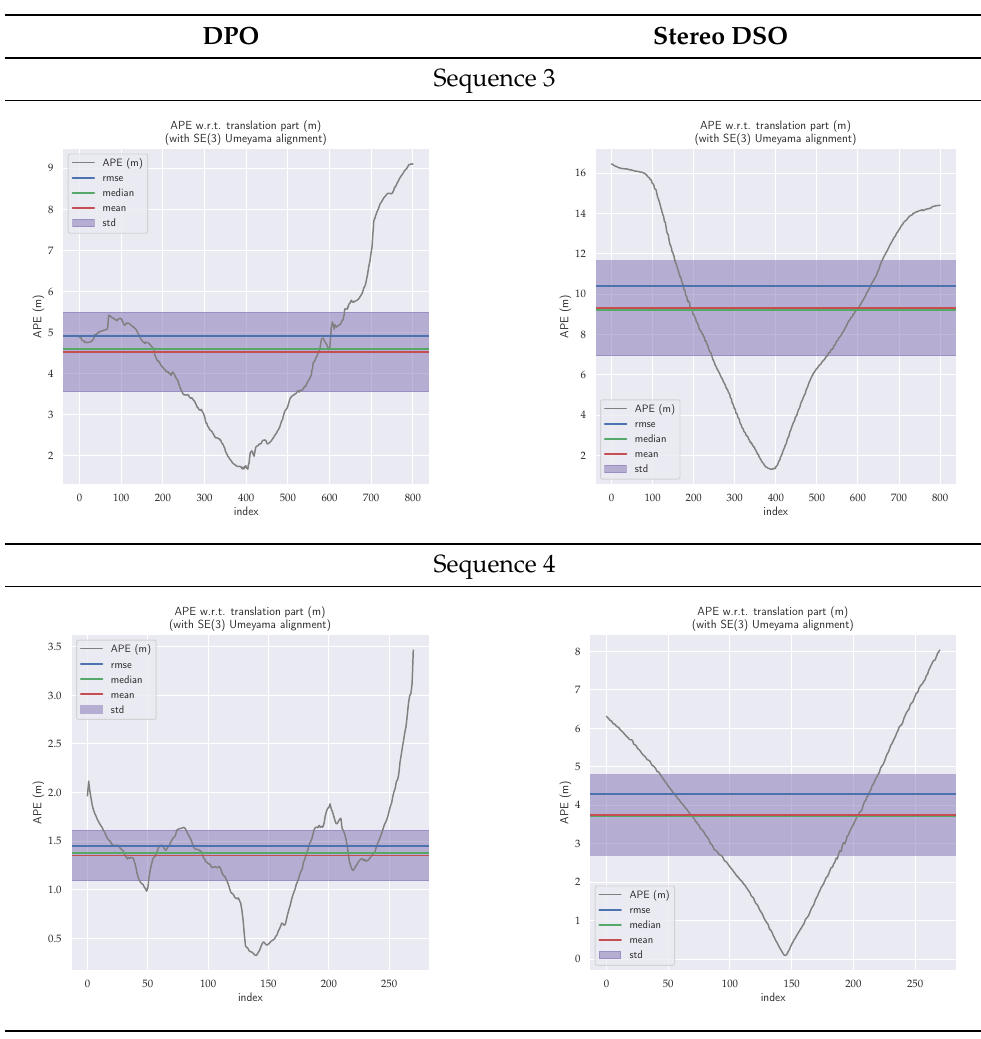
Table 1. The absolute pose error (APE) for all frames of sequences 3 and 4 of the KITTI dataset.